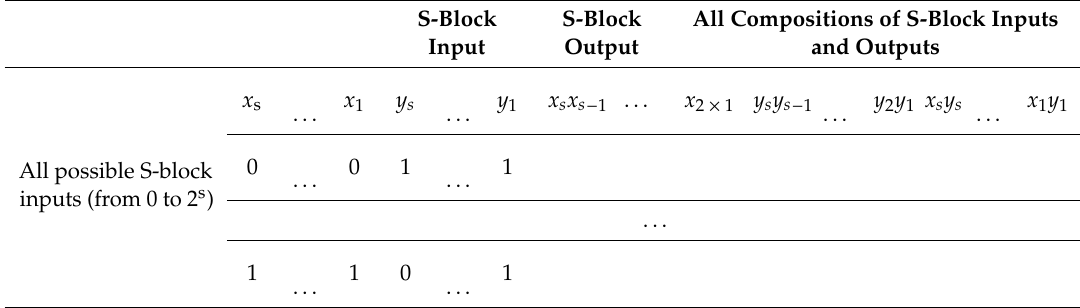
Table 4. Truth table for an s-bit